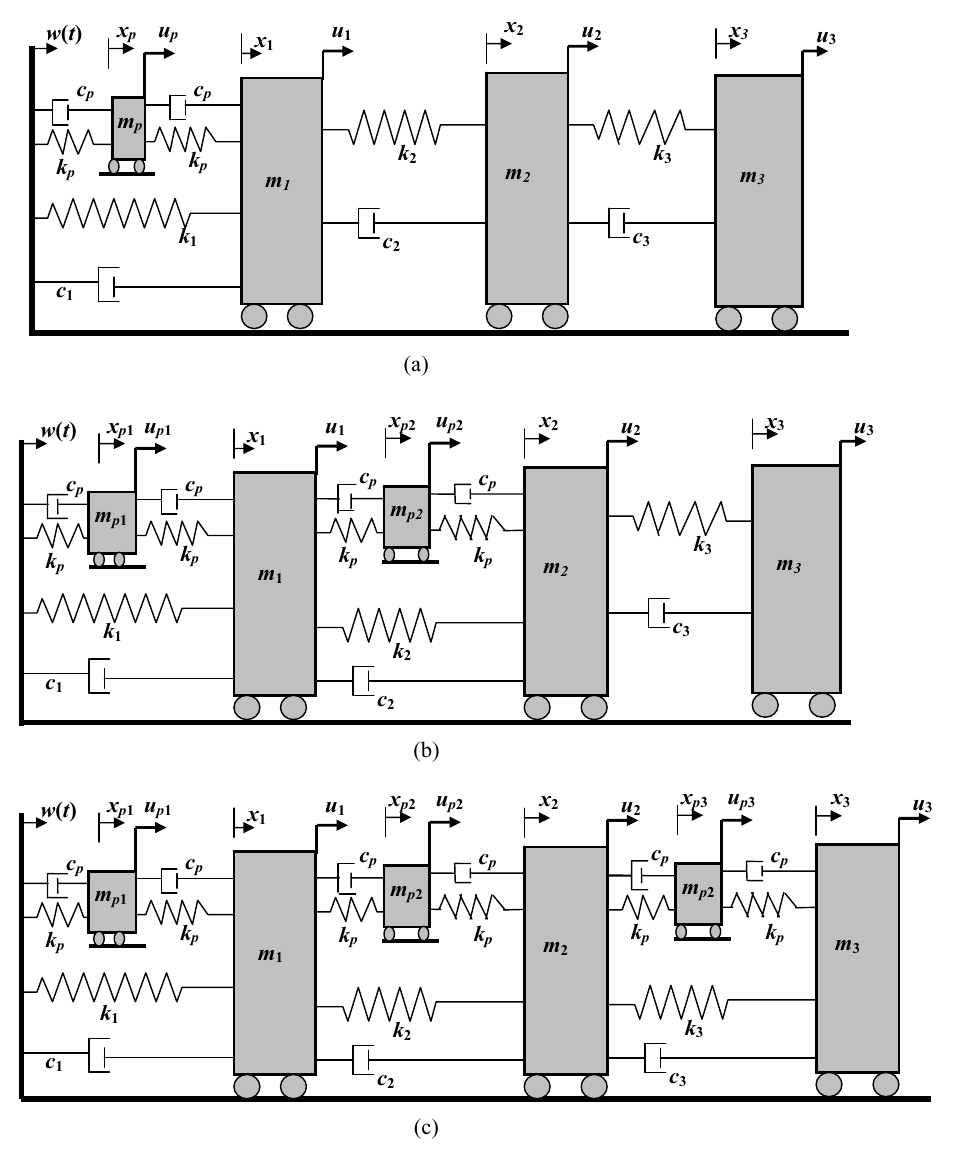
Fig. 1. (a) Three DOF oscillator with one passive element (configuration 1); (b) Three DOF oscillator with two passive elements (configuration 2); (c) Three DOF oscillator with three passive elements (configuration